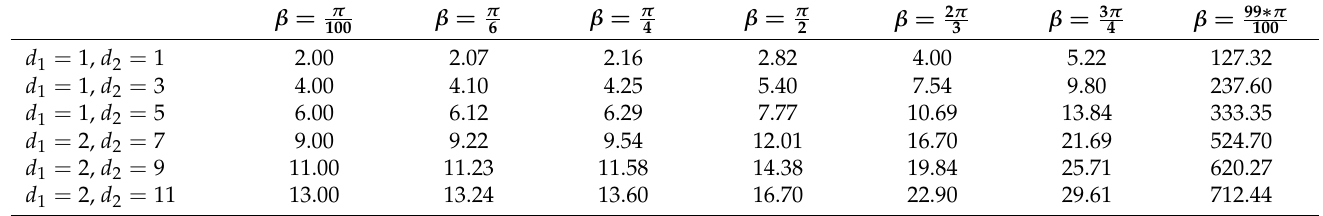
Table 1. l maxLength ( β ) for the different values of the parameters by employing the code from Listing